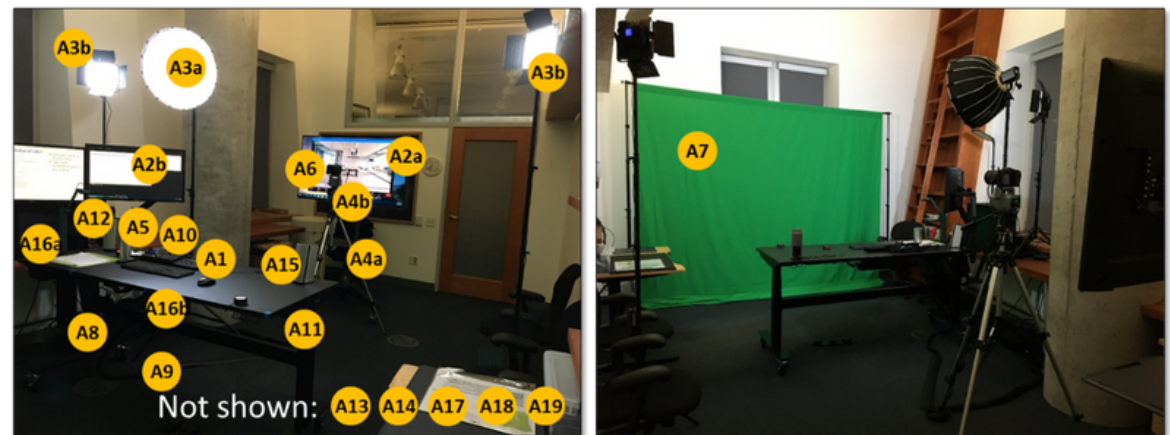
Figure C1. Andrew Lo’s studio at MIT CSAIL with labeled